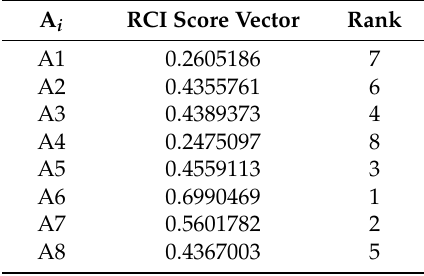
Table 5. The RCI scores assessed by TOPSIS for the alternatives and the rank